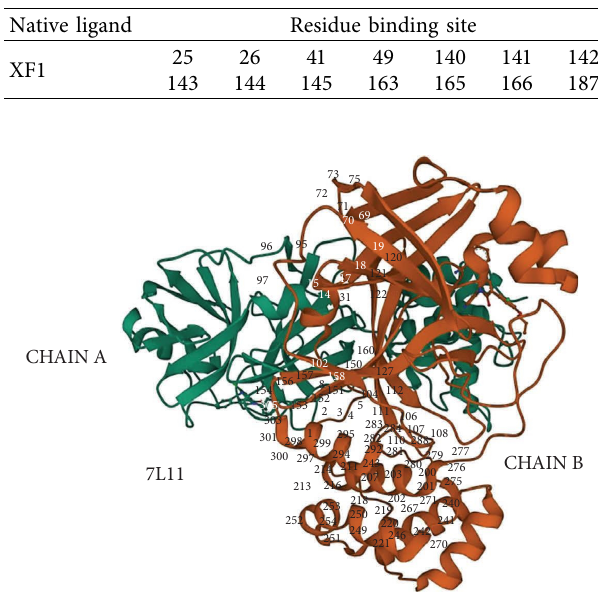
Table 2: Residue binding site of main protease enzyme of SARS-CoV 2 (PDB ID: 7L11) which is derived from the PDB site [22].